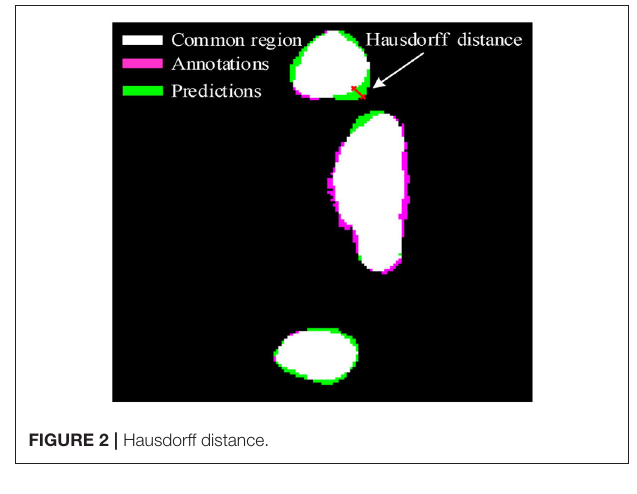
FIGURE 2 | Hausdorff